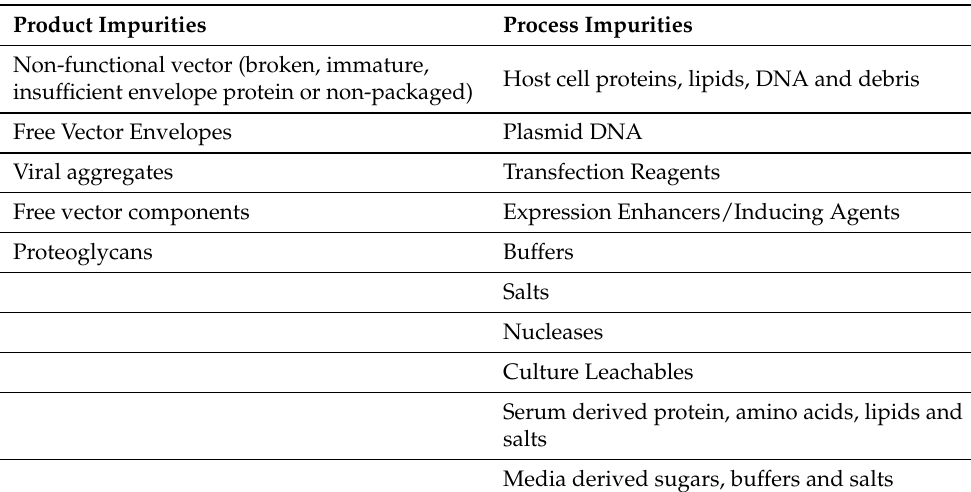
Table 1. Common impurities within the processing of lentiviral